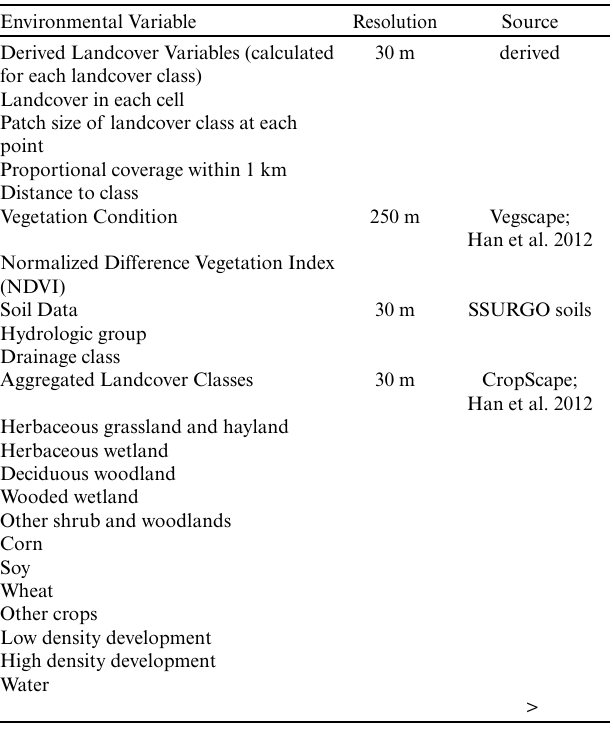
Table 1 . Environmental data used to predict relative avian abundance including consolidated landcover classes and derived variables, vegetative condition, and soil